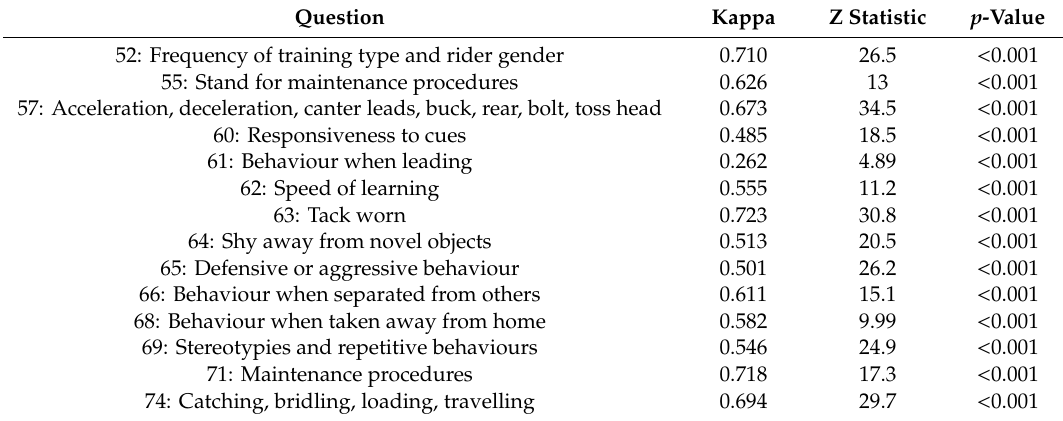
Table 7. Intra-rater reliability results. Each E-BARQ question listed is a matrix containing multiple individual items. Supplementary File S3 shows question numbers and question text for each matrix. The table shows Kappa scores using linear weighted Kappa